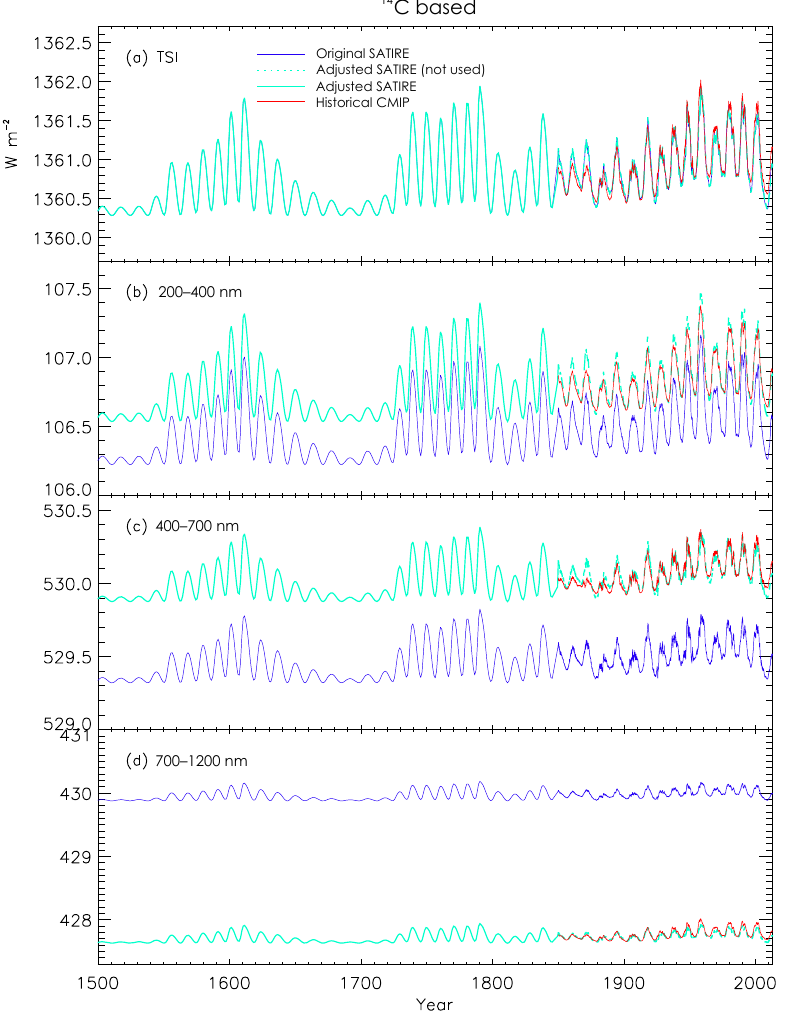
Figure 4. Adjustment of the 14 C/SATIRE-based reconstruction to the CMIP6 historical forcing (Matthes et al., 2017). TSI (a) and SSI (b– d) in three broad spectral intervals (in the UV between 200 and 400nm, in the visible at 400–700nm, and in the near-IR at 700–1200nm wavelength). The blue lines are the original 14 C/SATIRE-based time series, the cyan lines represent the adjusted data, and the red line is the CMIP6